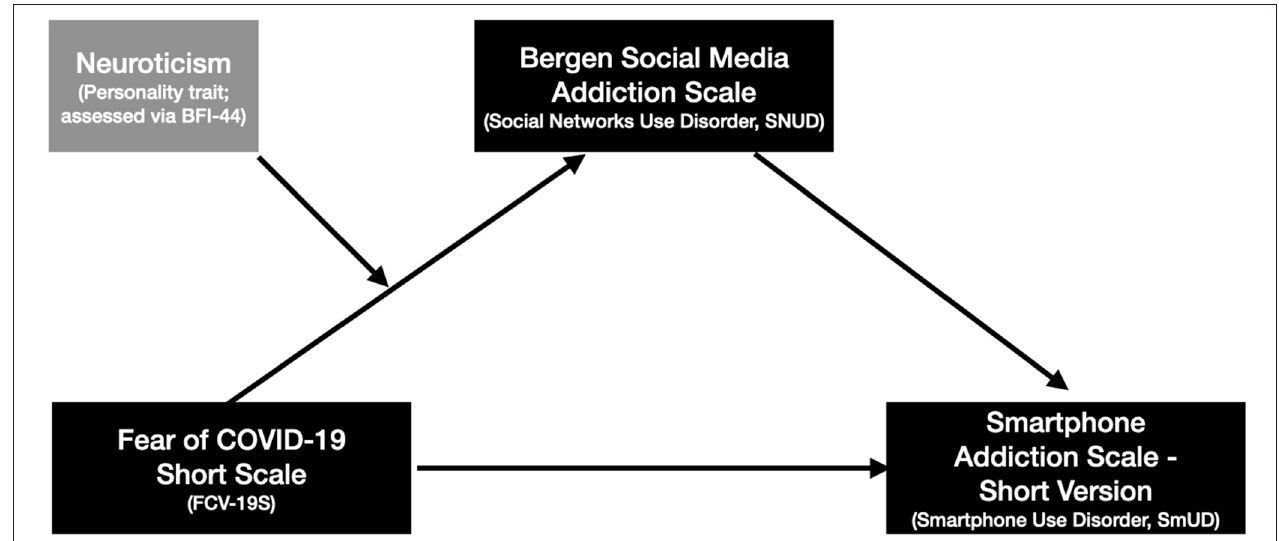
FIGURE 1 | The hypothesized research